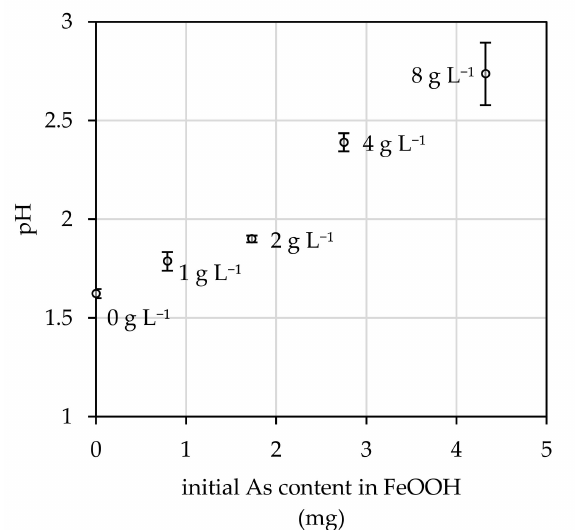
Figure 4. E ff ect of fungal Aspergillus niger 19-day static cultivation period on acidification of culture media supplemented with arsenate-treated FeOOH. Results represent the mean values of four independent experiments, and the error bars show the standard